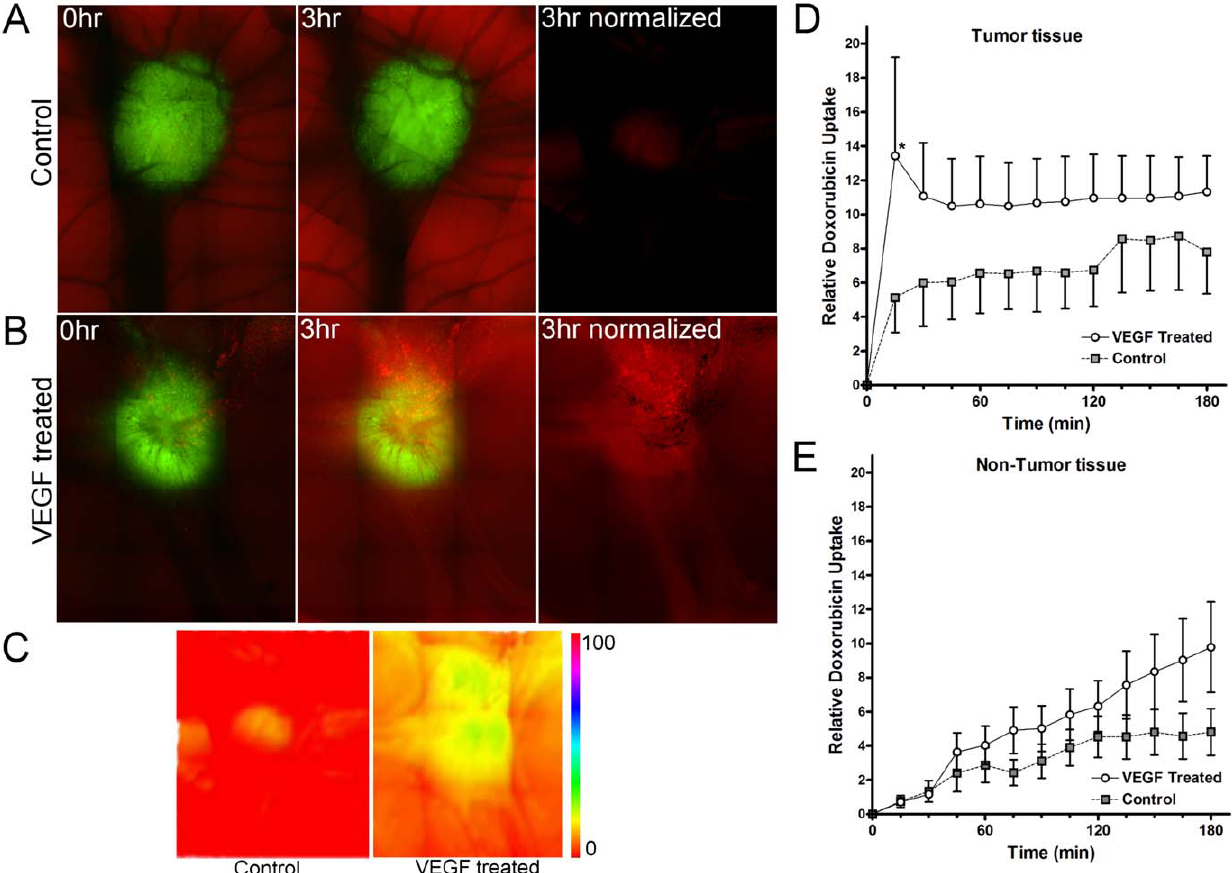
Figure 4. Increasing vascular permeability enhances the accumulation of doxorubicin into the tumor. Doxorubicin was injected intravenously subsequent to administration of PBS or VEGF and its uptake at the tumor site in real time was estimated using its natural fluorescence. A–B. Representative images of doxorubicin uptake over time, tumors (green) and doxorubicin uptake (red) are shown. C. Heat map of doxorubicin uptake after 3 hours in control and VEGF-treated tumors. D. Graph showing relative uptake of doxorubicin in the tumor in the presence or absence of systemic VEGF treatment. E. Graph showing relative uptake of doxorubicin in the normal tissues distal to the tumor in the presence or absence of systemic VEGF treatment. N=4 per treatment; data were analyzed by 2 way